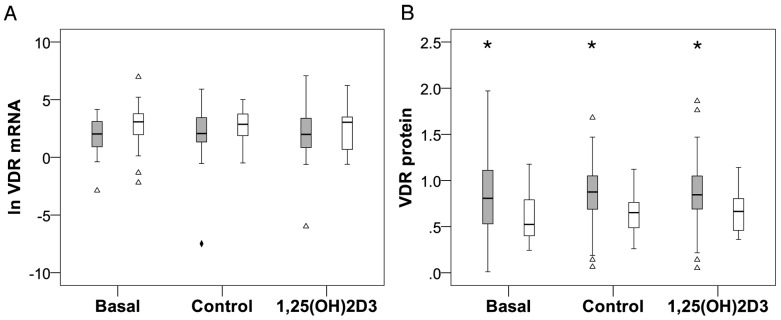
Ethnicity influenced VDR mRNA and protein level.
In vitro VDR expression (A) and protein level (B) were quantified in monocyte-macrophages from healthy Africans (grey, n = 40) and Whites (white, n = 20), using RT-qPCR and flow cytometry respectively. Monocytes were analysed directly after isolation (Basal), or cultured for 24 h with 10 nM 1,25(OH)2D3 or vehicle control. Box plots show data distribution: boxes illustrate 50% of cases or interquartile range (IQR, 25th to 75th percentile); horizontal lines, median; whiskers, 1.5 IQR from box, or minimum or maximum values if no case has a value in that range. Africans displayed more variance than Whites as illustrated by the distribution IQRs and outliers (Δ, 1.5 to 3 IQR from box) and extreme outlier (♦, >3 IQR from box). Approximately 95% of the data lie between whiskers. Two-way ANOVA showed an overall, significant main effect for ethnicity; Africans having lower VDR mRNA (P<0.050) but higher protein level (P<0.001) compared to Whites. Fisher's LSD test showed a significantly higher mean VDR protein level in Africans compared to Whites under all conditions (* P<0.050). VDR mRNA data was ln-transformed to meet the assumptions of parametric statistical tests.